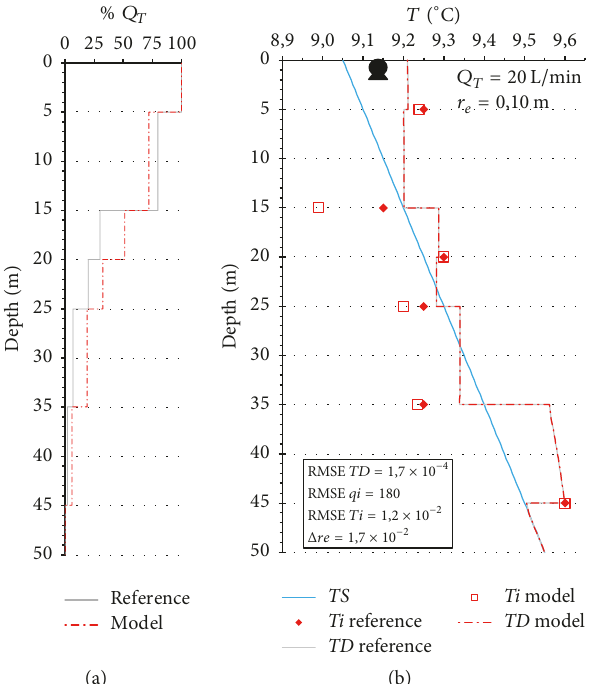
Figure 8: Results of 𝑇 𝐷 (𝑧) modelling with the heat budget at 𝑄 𝑇 = 20L/min. (a) Flow-depth distribution; (b) dynamic temperature profiles ( 𝑇 𝐷 (𝑧) ) and temperatures of inflows ( 𝑇 𝑖 (𝑧)